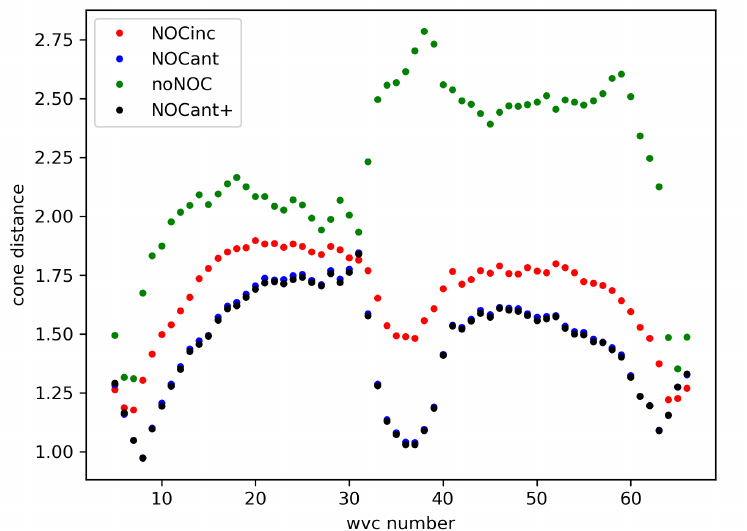
Figure 13. Average MLE (cone distance) as a function of WVC for Ku-band ascending orbits with respect to NSCAT4-DS [9] (noNOC is green, NOCinc is red, NOCant is blue, NOCant+ is black).